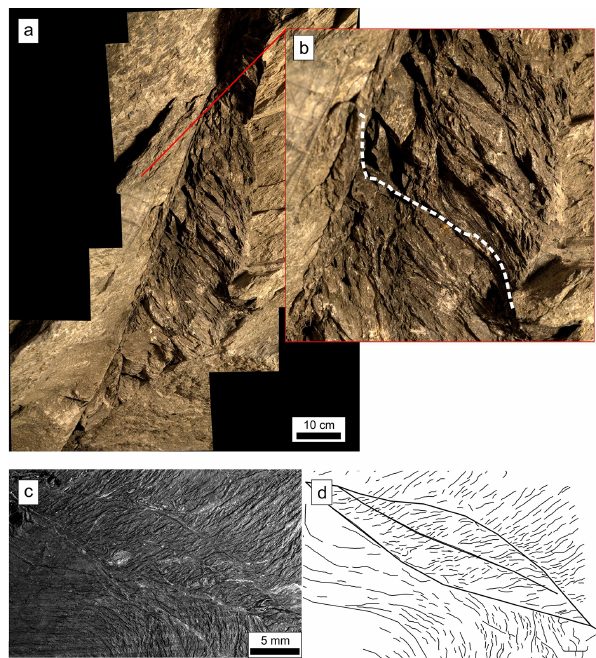
Figure 14. S-C foliations. (a) and (b) in outcrop scale, viewing di- rection WSW at Gallery 98 (view Fig. 1 for location). (c) and (d) in mm scale in drill core sample BPS12-4 (location shown in Fig. 15).